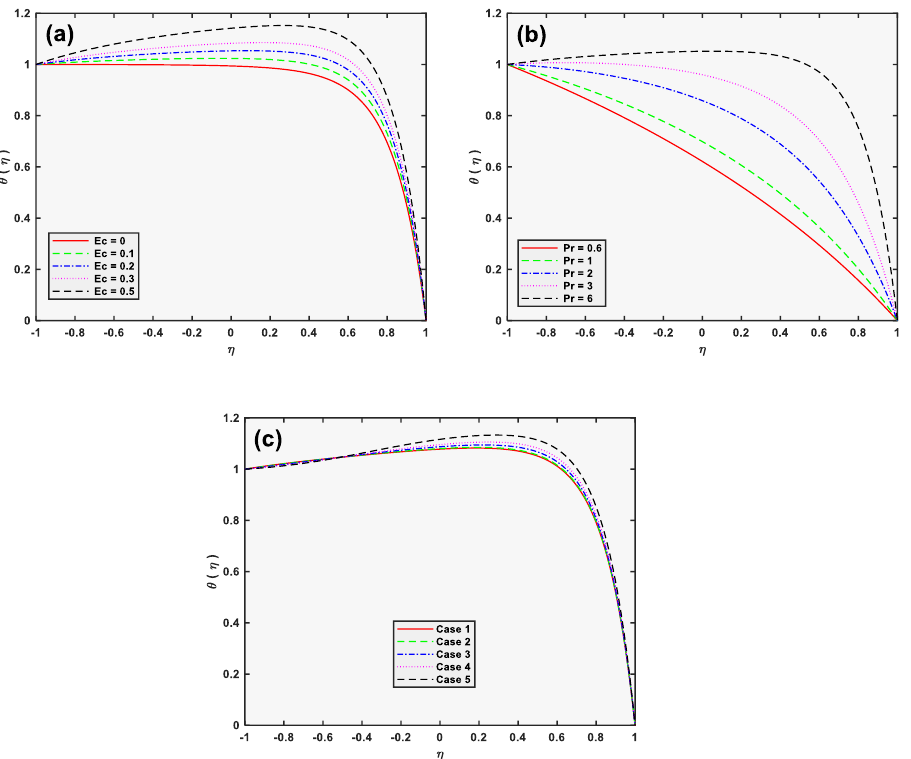
Figure 5. Impact of different parameters on temperature profile ( a ) Eckert number; ( b ) Prandtl number; ( c ) Various cases of Micropolar parameter.